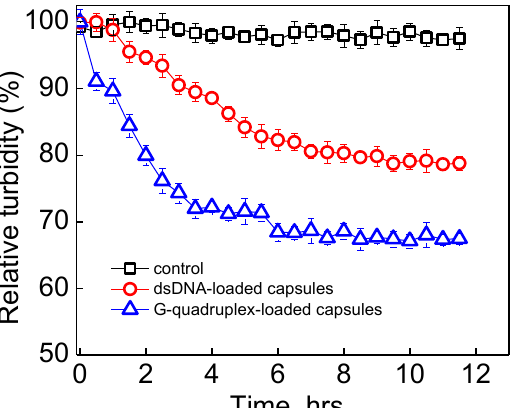
Figure 5. Relative solution turbidity of dsDNA-loaded (red circles), G-quadruplex DNA-loaded (blue triangles) (PMAA/PVPON) 13 hydrogel capsules incubated with 5 mM GSH (0.01 M phosphate, pH = 7.4) at 37 °C and non-treated control empty (PMAA/PVPON) 13 (black squares). The data is presented as mean ± SD. For each marker, five measurements within 1 min of the timepoint were averaged.